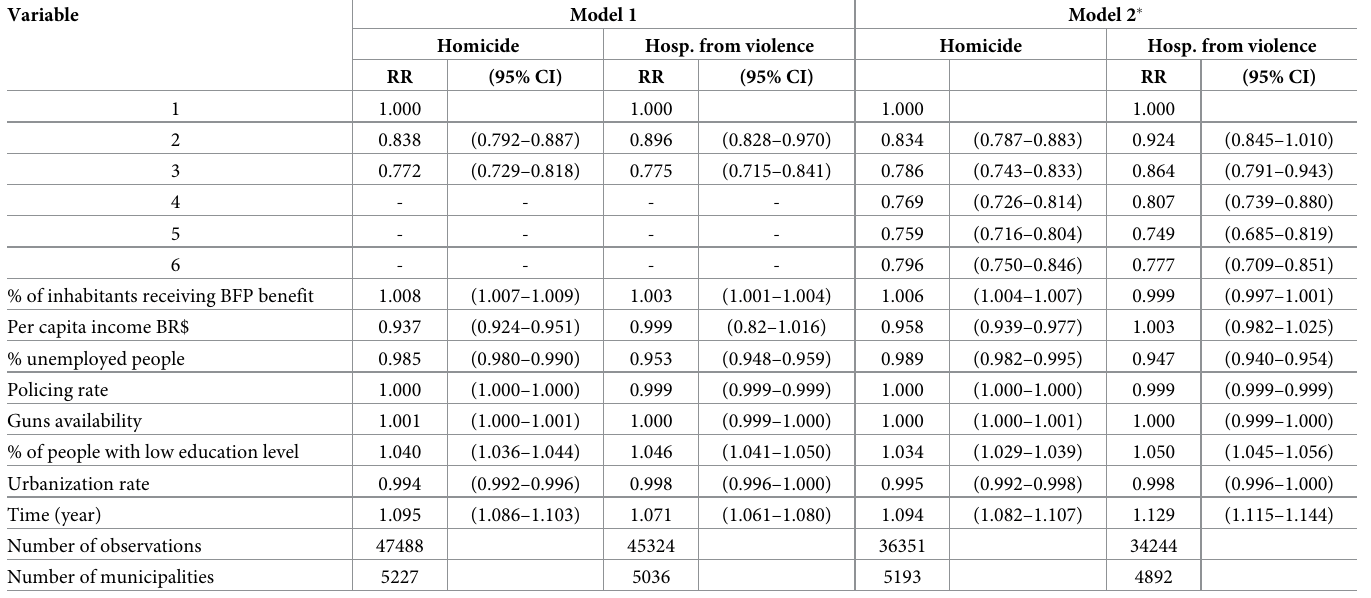
Table 3. Fixed effect regression models for adjusted associations between homicide rates or hospitalizations from violence and BFP coverage in the Brazilian municipalities by coverage level and duration, 2004–2012. Variable